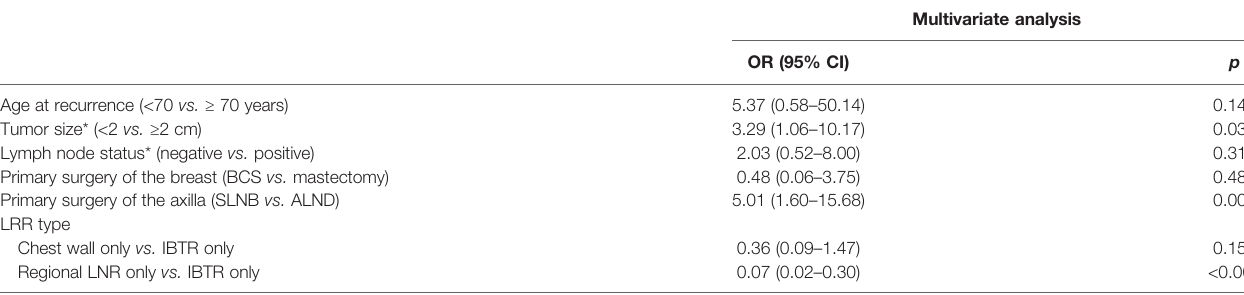
TABLE 4 | Multivariate analysis for clinicopathological features related to salvage surgery decision for LRR patients.